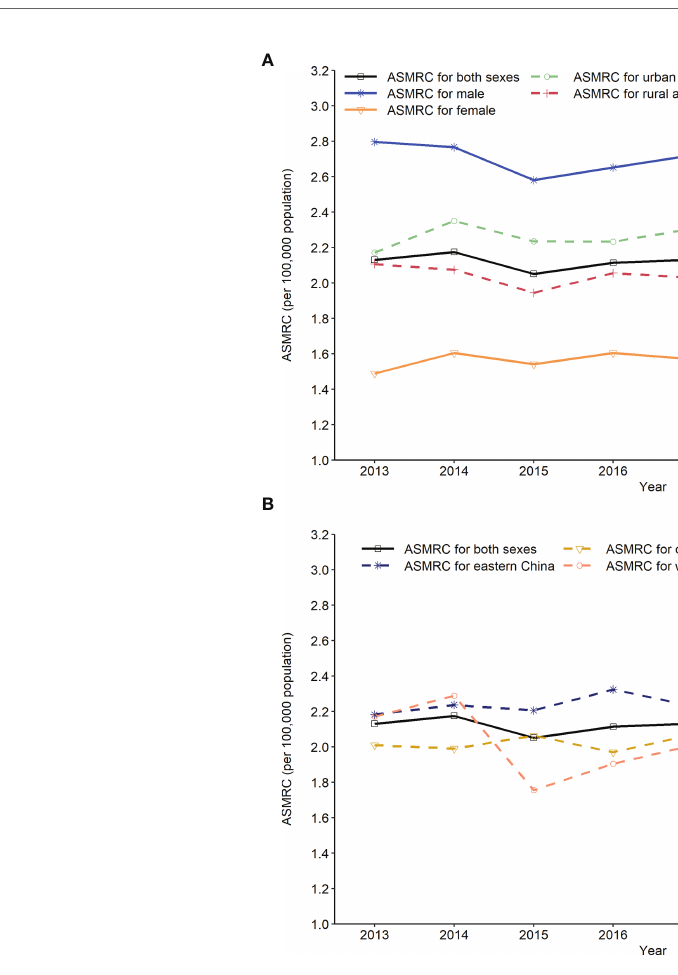
FIGURE 3 | Trends in age-standardized mortality rate of China (ASMRC) of lymphoma by sex, residence and region in China, 2013 to 2020. (A) Trends in ASMRC of lymphoma by gender and residence, (B) Trends in ASMRC of lymphoma by